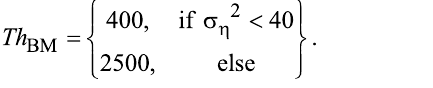
Data-adaptive noise